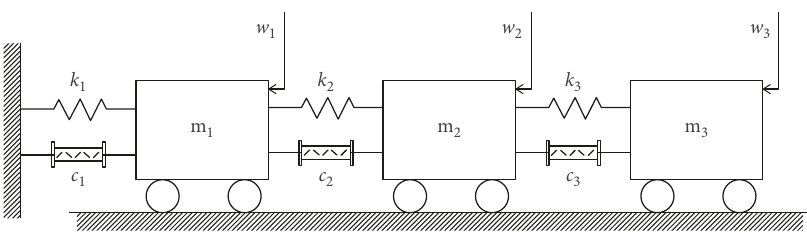
Figure 2: 3-DOF vibration system. Table 1: Theoretical modal parameters of a 3-DOF